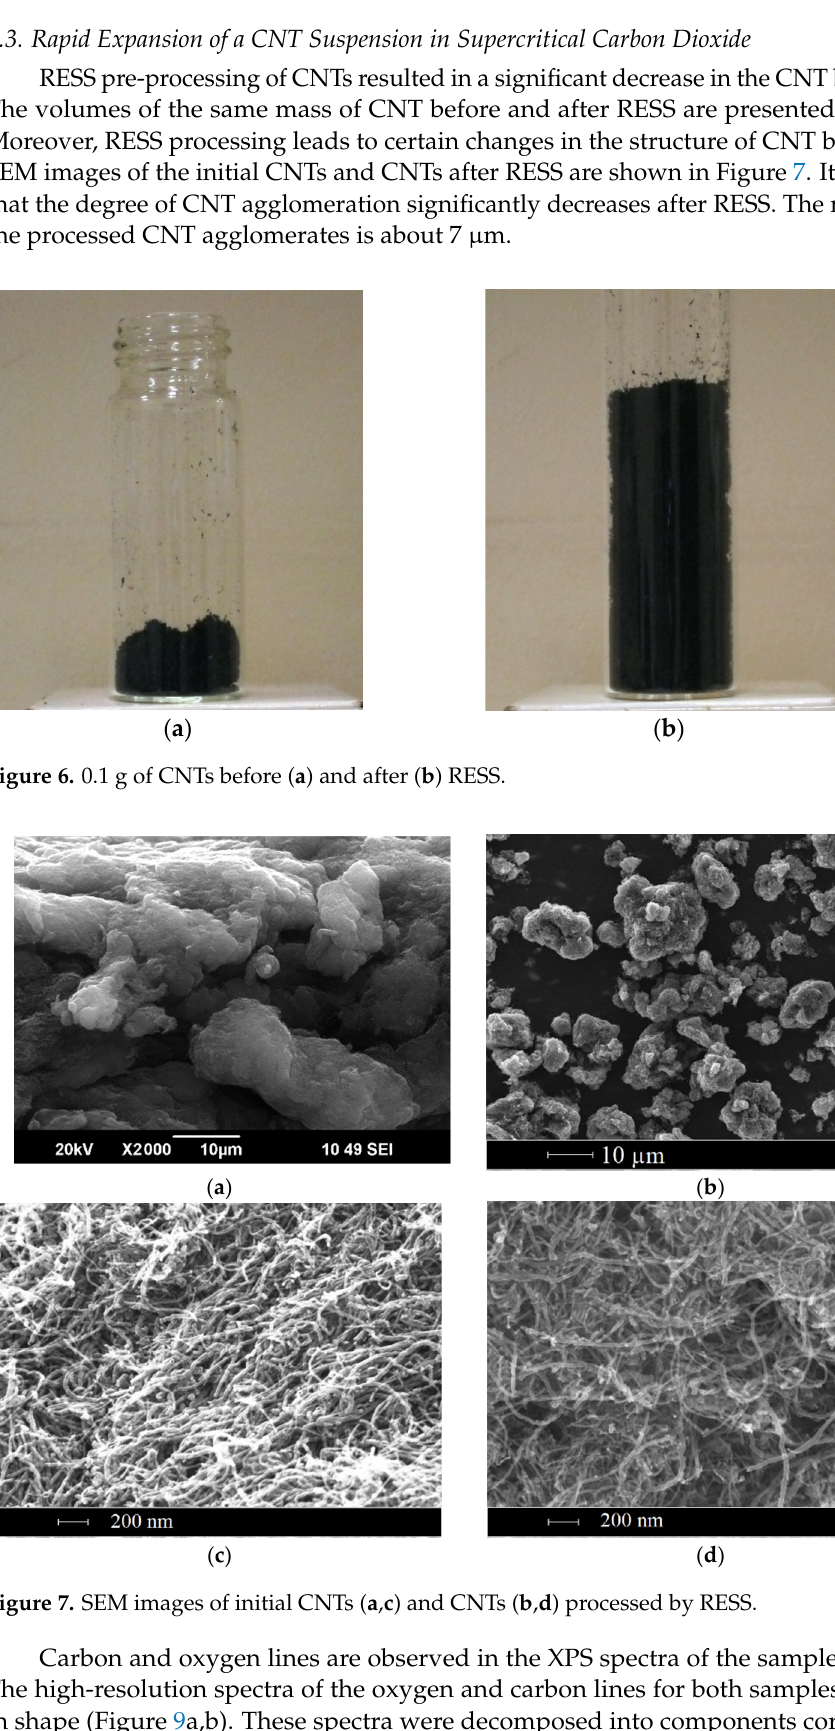
Figure 5. SEM images of the PC-carboxylated carbon nanotube (CNT) composite powder at 500× ( a ) and 6000× zoom ( b ).